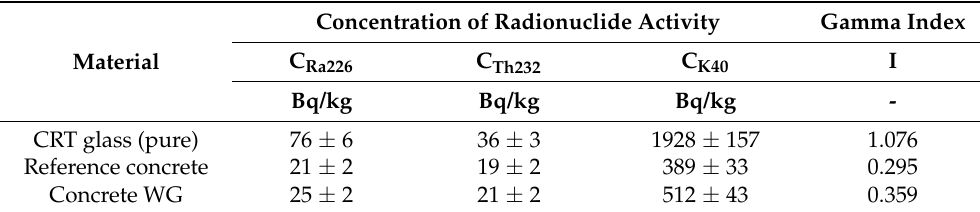
Table 6. Concentrations of radionuclide